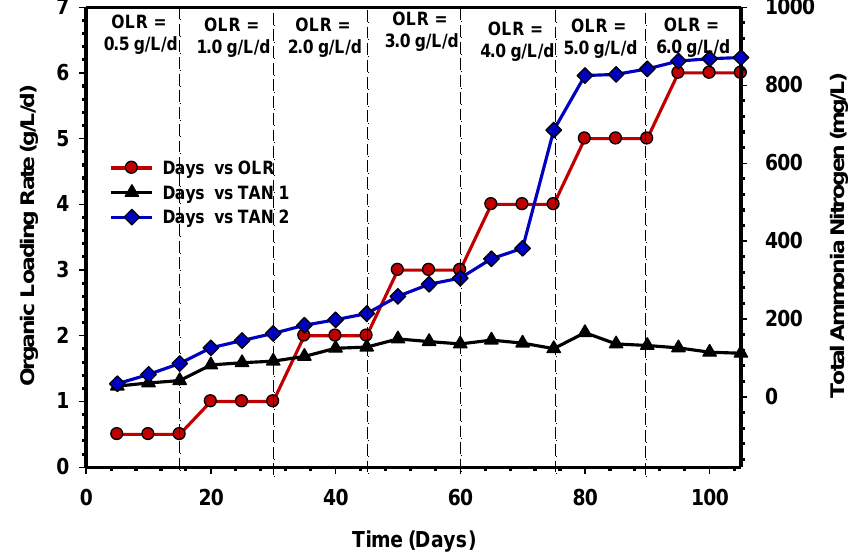
Figure 8. TAN concentration in UASB 1 and 2 over time. Nonetheless, a significant difference was seen when the OLR was increased to 4, 5, and 6 gCOD/L/d to reactors, in which the values of TAN in UASB 2 increased from 685 mg/L at 4 gCOD/L/d to 813 mg/L at 6 gCOD/L/d, while it decreased from 135 mg/L at 4 gCOD/L/d to 112 mg/L at 6 gCOD/L/d in the UASB 1 reactor. Consequently, the differ- ences that occurred as a result of increasing OLR in both reactors depict that protein hy- drolysis was not occurring in UASB 1, and therefore, assimilation of COD by microbial population did not show progress, indicating that microorganisms (acetogens and meth- anogens) were not growing. Furthermore, the rapid breakdown of organic matter by the vast population of microbial biomass could be explained by the high production of TAN in the UASB 2 reactor. Comparatively, at low OLR, the performances of the reactors at steady states were quite stable. Nevertheless, after increasing the concentration of CSWW, UASB 2 demonstrated higher degradation of the substrate, indicating that the reactor was more efficient than UASB 1 at converting organic matter to methane at greater OLR. On the other hand, the TAN concentration in UASB 2 reactor ’ s effluent remained stable and did not hinder or create any substantial changes in the reactor ’ s functioning at higher OLR.